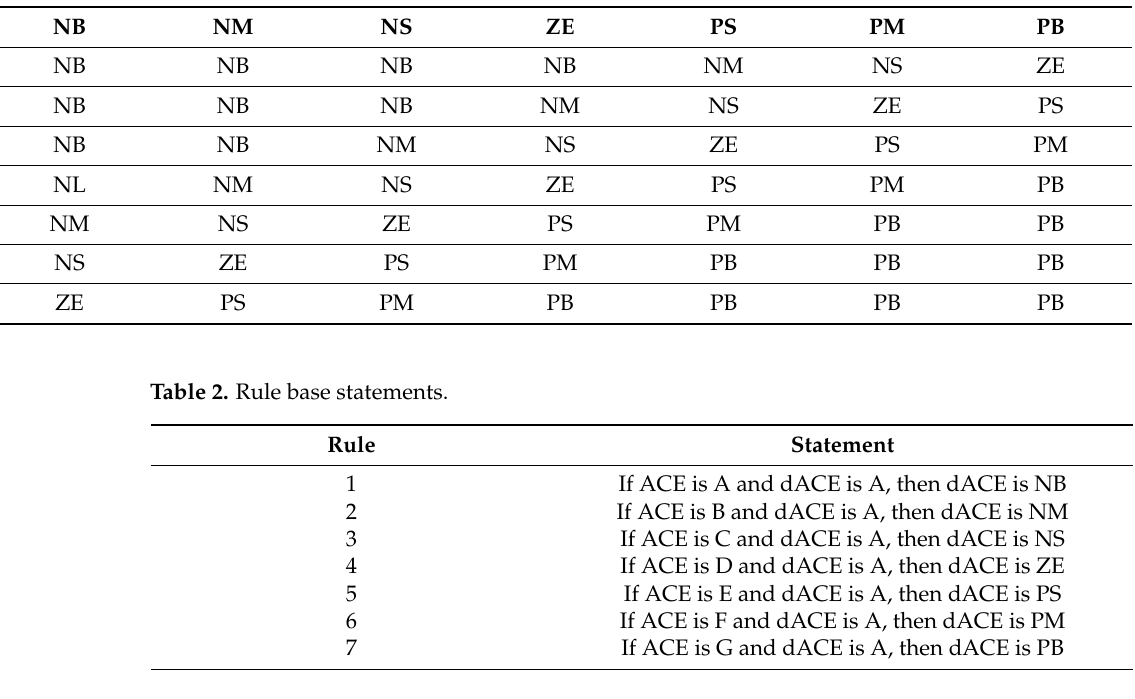
Table 1. Fuzzy Type-2 FOPID rule base.